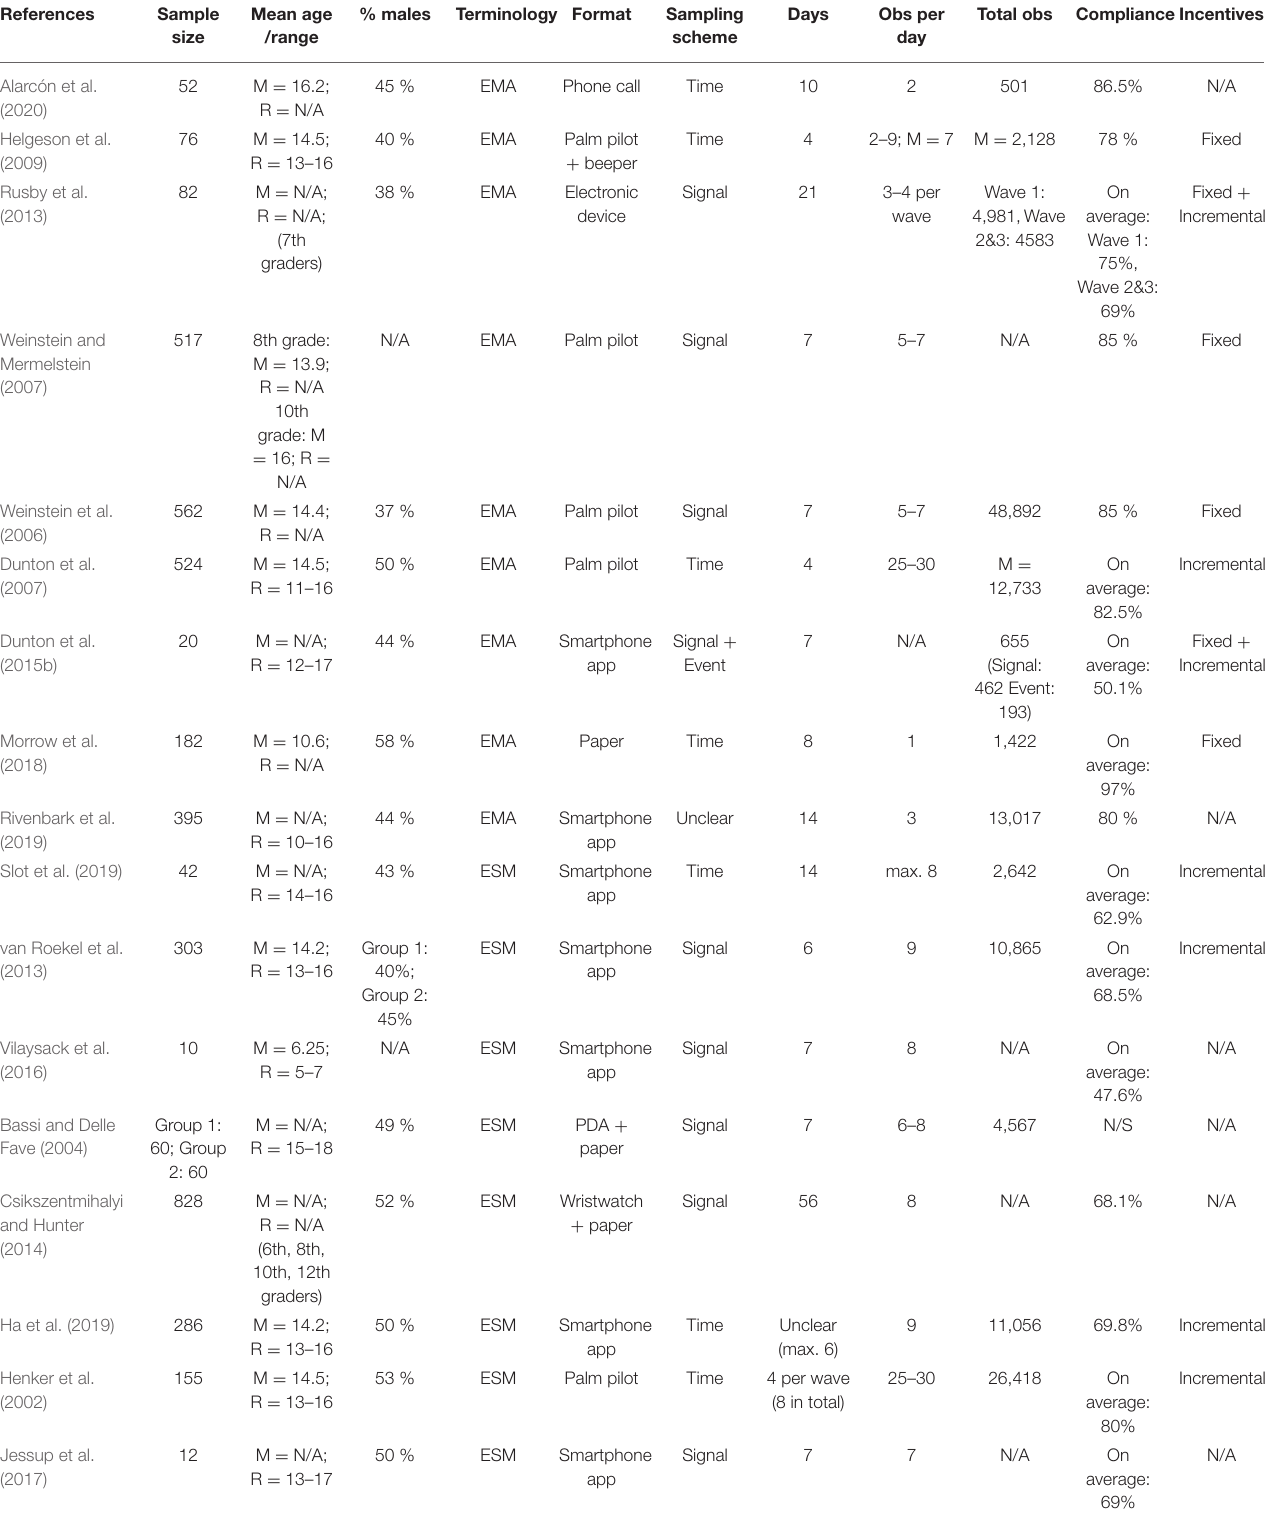
TABLE 1 | Characteristics of included studies ( N =